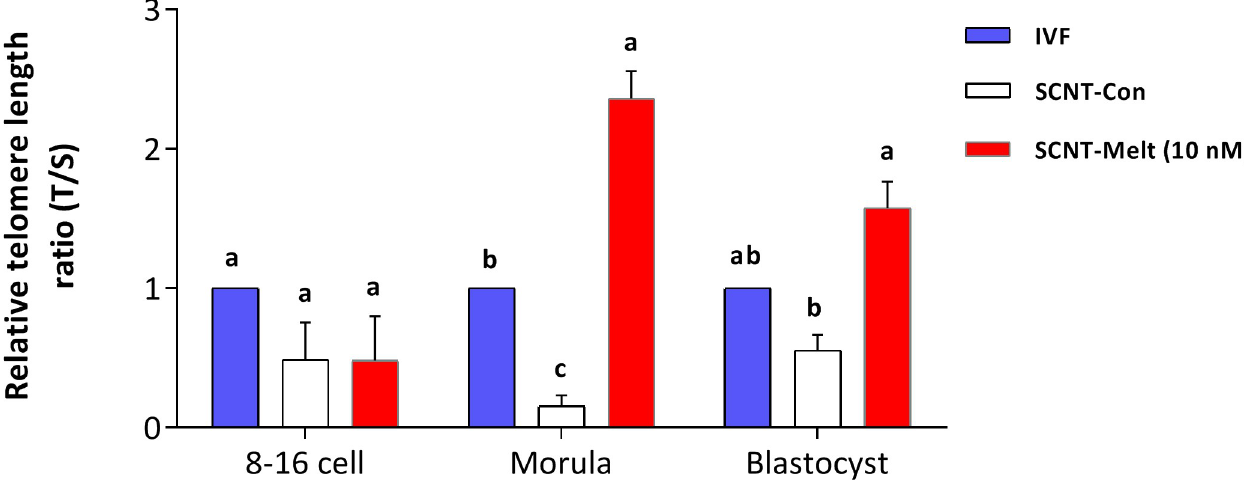
Fig 8. Effects of melatonin on the relative telomere length of SCNT derived blastocysts. The relative telomere length between SCNT-Melt (10 nM) and SCNT-Con embryos at 3 distinct developmental stages (8-cell, morula and blastocyst) was evaluated by RT-qPCR. The telomere length of IVF-derived embryos was evaluated as standard group. The data were shown as mean ± SEM. Values with different letters have a statistically significant difference ( P < 0.05).